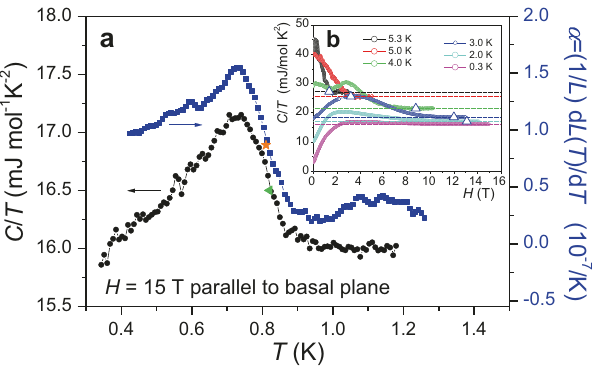
Fig. 3 Thermodynamic bulk probes displaying the upper critical fi eld H c2 transition of NbS 2 in high parallel magnetic fi elds. a Speci fi c heat C / T (circles) and linear thermal expansion coef fi cient α ¼ ð 1 = L Þ d L ð T Þ = d T (squares) of NbS 2 showing the superconducting transition in a magnetic fi eld of 15 T applied strictly parallel to the layer structure. The additional orange star and tilted green triangle mark the transition midpoints to be included in the phase diagram in Fig. 5. b Speci fi c heat of NbS 2 measured with an ac technique with a small 1 mK temperature modulation during fi eld sweeps at different fi xed temperatures. The triangles mark the fi elds in which the constant normal state-speci fi c heat value (dotted lines) is reached.